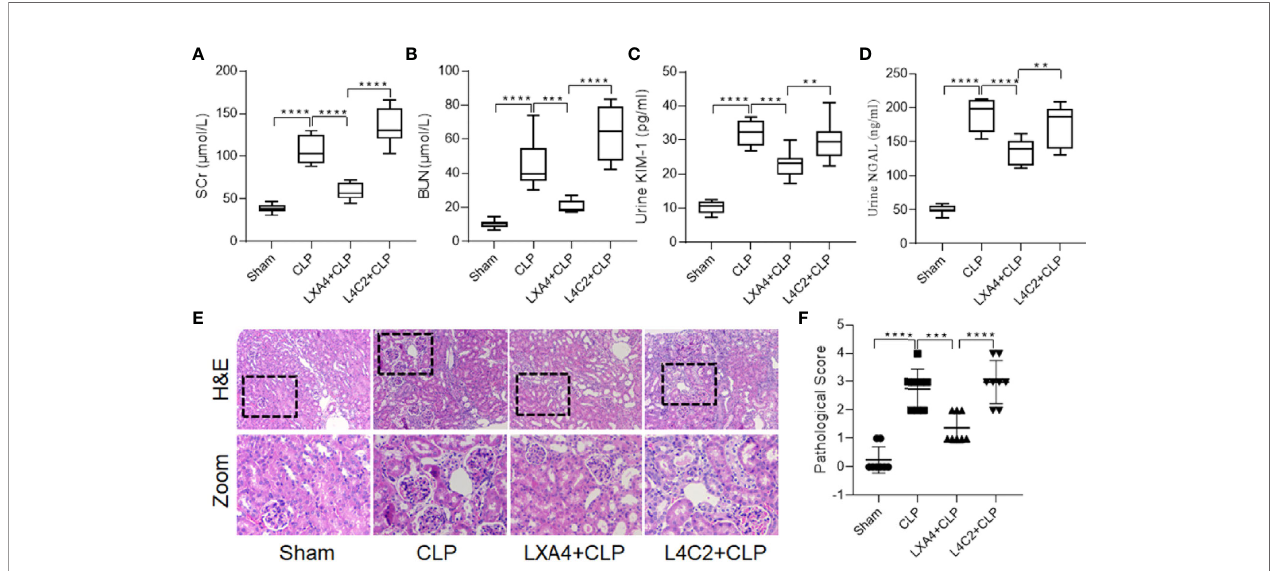
FIGURE 3 | LXA4 alleviates septic AKI. Male Sprague-Dawley rats were treated with or without LXA4 (100 µg/kg, i.p. ) for 30-min or BOC-2 (50 mg/kg, i.p. ) for 20min before CLP and were sacri fi ced at the time point of 18-h after surgery. Renal function alternation and renal necrosis were detected. (A – D) levels of SCr, BUN, urinary KIM-1 and NGAL among the four groups. (E) Renal damage of rats among the four groups (H&E; scale bar 100 m m). (F) Kidney histopathology evaluation scores among the four groups. Data are presented as mean ± SE (n = 8). ** p < 0.01; *** p < 0.001; **** p < 0.0001; LXA4, Lipoxin A4; CLP, cecal ligation and puncture; H&E, hematoxylin – eosin staining; SCr, serum creatinine; BUN, blood urea nitrogen; KIM-1, kidney injury molecule-1; NGAL, neutrophil gelatinase- associated